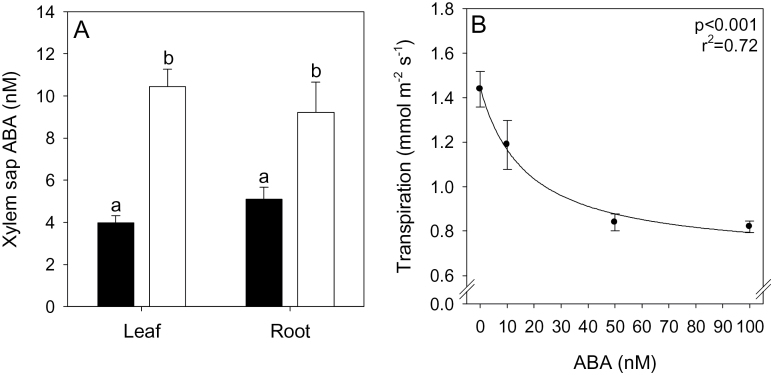
Root and leaf xylem sap ABA concentration (A) of limed (open bars) or unlimed (filled bars) Pisum sativum grown in a whole-plant pressure chamber. (B) The relationship between artificial xylem sap ABA concentration and transpiration rate in detached leaflets of P. sativum. Data are means ±SE of 5–6 (A) and 6–8 (B) replicates; different letters in (A) indicate significant differences (P<0.05) as determined by a Student t-test. A hyperbolic decay regression line is fitted in (B), with P-values and r
2 reported in the top right of the panel.